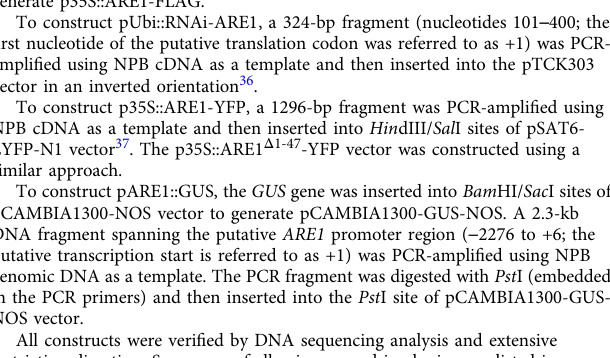
Supplementary Table 2. All binary vector-based plasmids were transformed into Agrobacterium tumefaciens strain EHA105 by electroporation and the resulting bacteria cultures were used for the transformation of